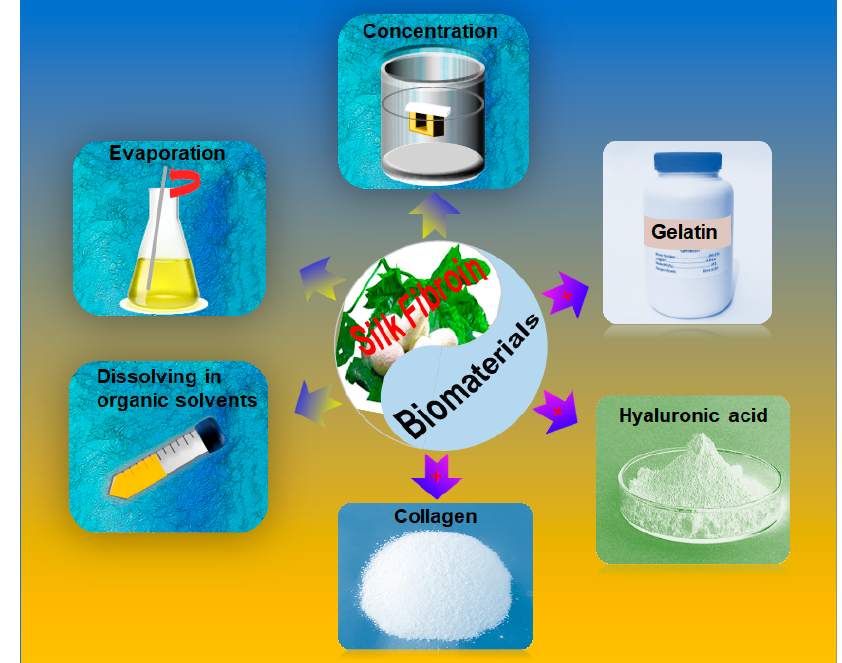
Figure 2. Schematic of methods to optimizing the rheology of SF bioink. SF is a biomaterial with impressive biocompatibility and mechanical properties. As a bioink, its rheology should be adjusted in aqueous system by different strategies. The gradient arrow without “+” indicated that their rheology could be regulated by concentration, evaporation, and dissolving in organic solvents; the arrow with “+” shows that SF solutions were combined with other biopolymers, such as collagen, hyaluronic acid, and gelatin, respectively, to enhance their rheology.